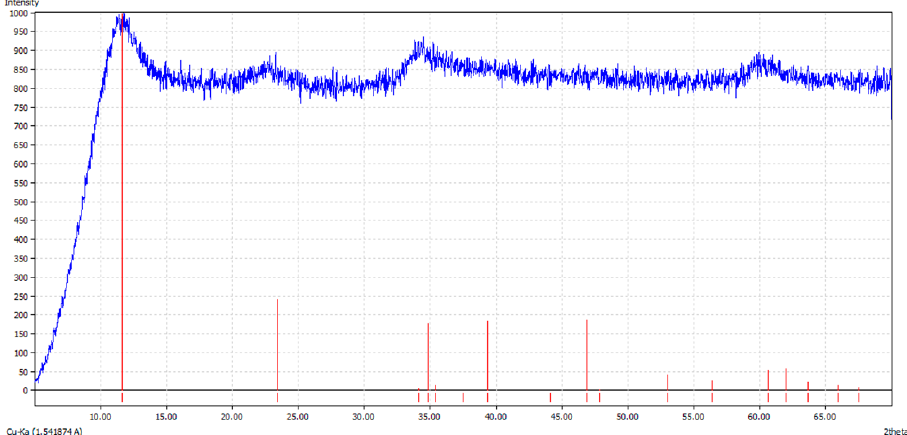
Figure 3. XRD of HTLC sample prepared (red lines correspond to hydrotalcite XRD pattern JCDP 010890460).